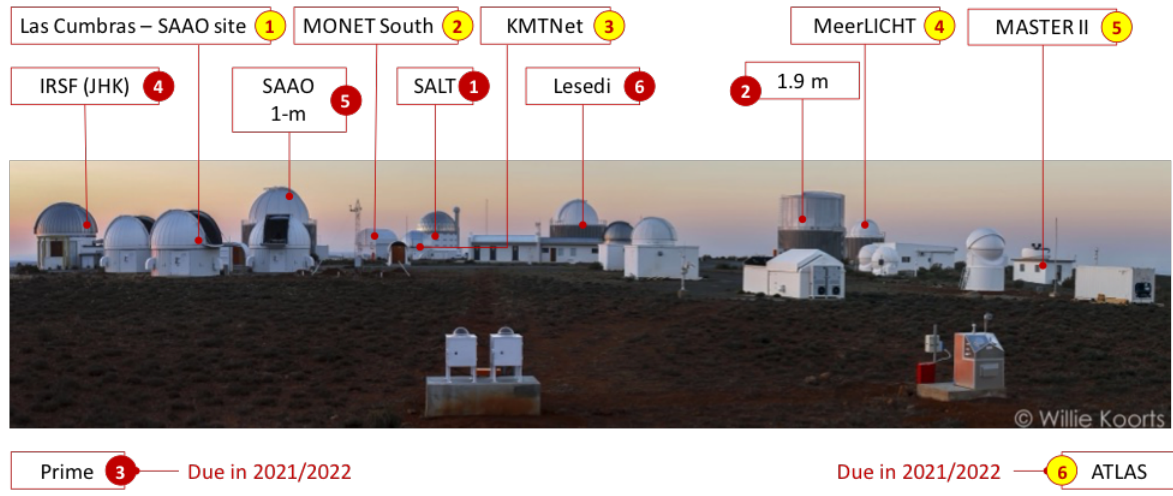
Figure 1. The telescopes of the Sutherland plateau (from SAAO, Intelligent Observatory Operational Concept Description